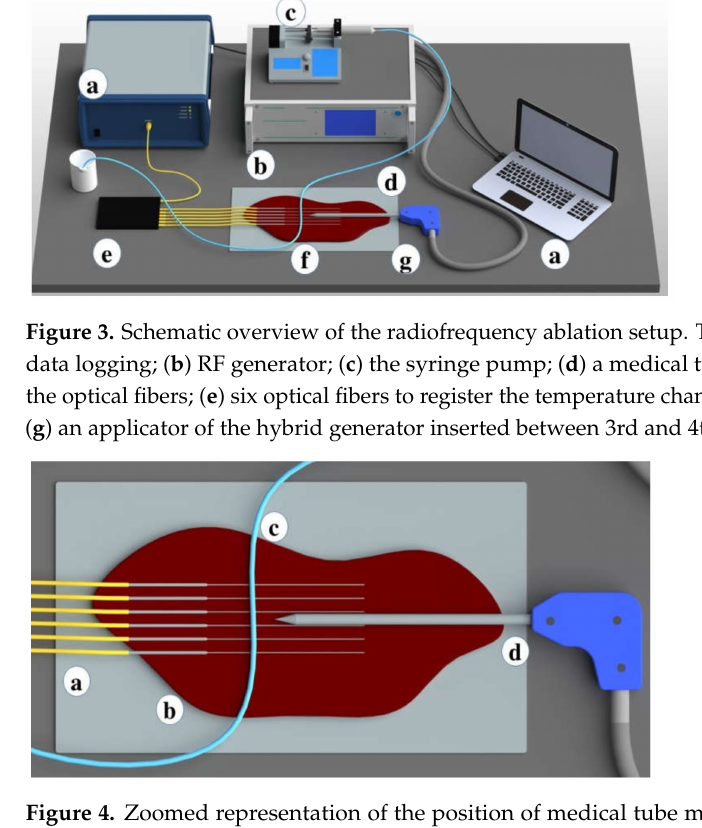
Figure 4. Zoomed representation of the position of medical tube mimicking the blood vessel and temperature sensing optical fibers on the tissue. The medical tube and optical fibers are located perpendicularly to each other on x-y plane. The setup consists of ( a ) optical fibers; ( b ) a bovine liver; ( c ) vessel located in parallel; and ( d ) an